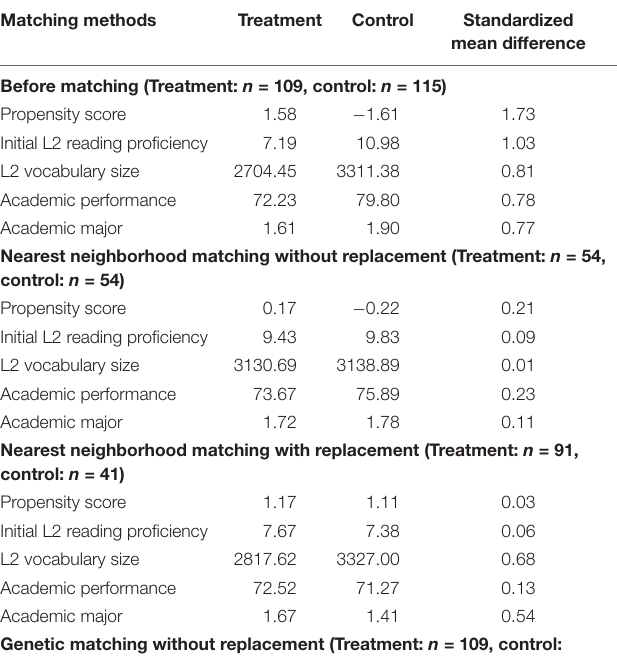
TABLE 6 | Differences in means of confounding variables by propensity score